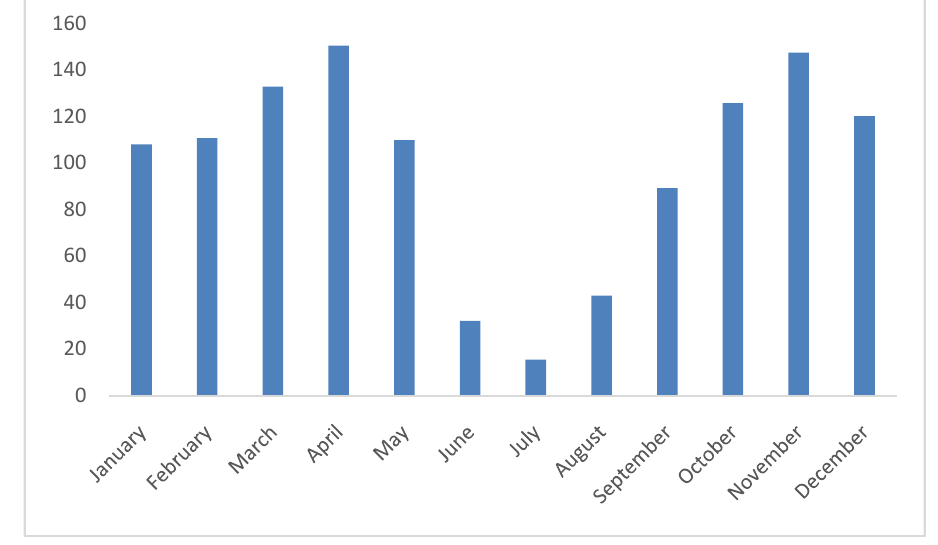
Fig. 2. Distribution of mean monthly rainfall (mm) in Rwanda, 2000  2012 Source: authors’ calculations based on data from the World Bank’s climate change portal,